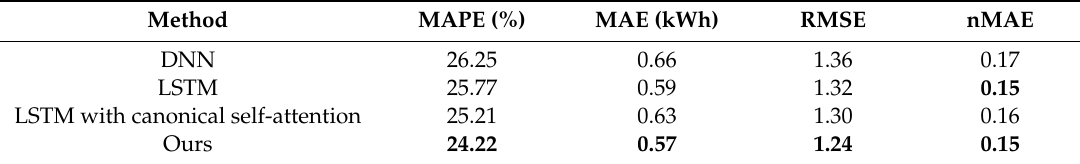
Table 3. Comparison of PV power generation forecasting performance. (The value in bold in each column is the minimum value.).